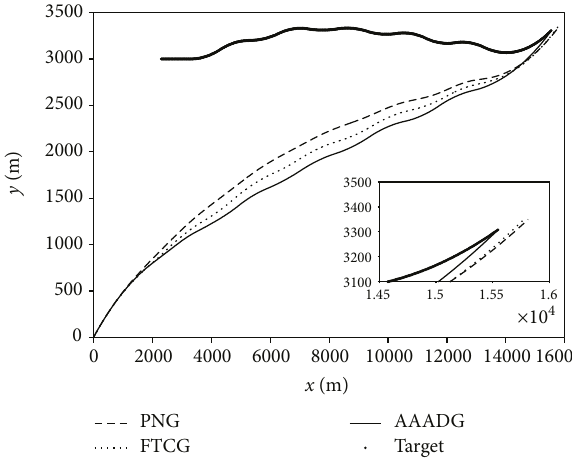
Figure 9: Trajectories of the interceptor and target under three guidance laws.